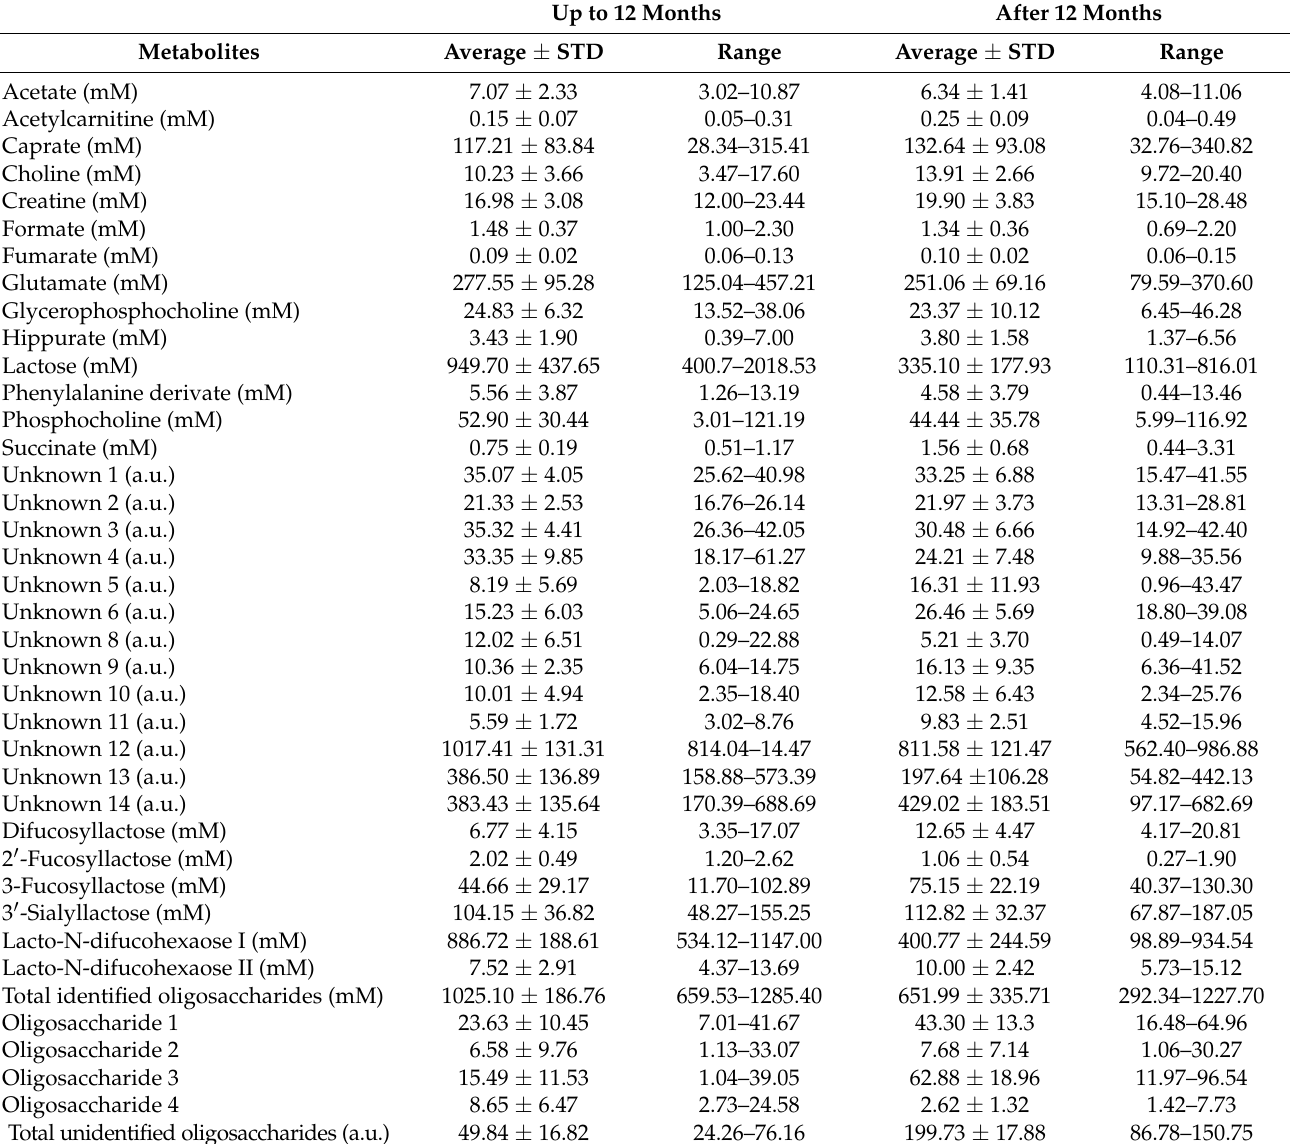
Table 2. Metabolite content of mature African elephant milk up to and after 12 months of